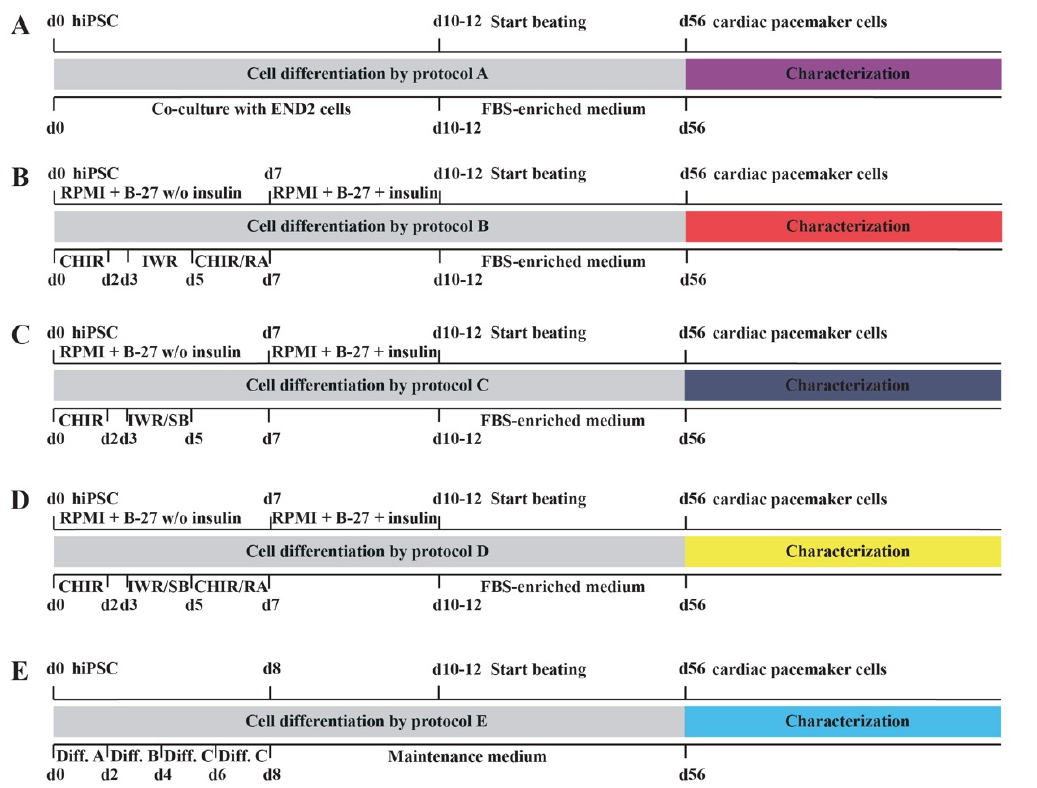
Figure 1. Schematic overview of the novel differentiation protocols. ( A ): Reference protocol A based on a co-culture of hiPSC and END2 cells. ( B – D ): Novel protocols ( B – D ) based on activation (6 µM CHIR 99021 on days 0 + 1) and inhibition (5 µM IWR-1 on days 3 + 4) of Wingless/Integrated (Wnt)